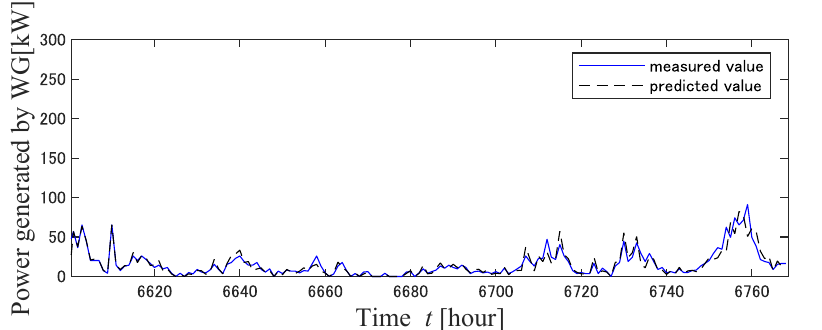
Figure 12. Power generated by WG